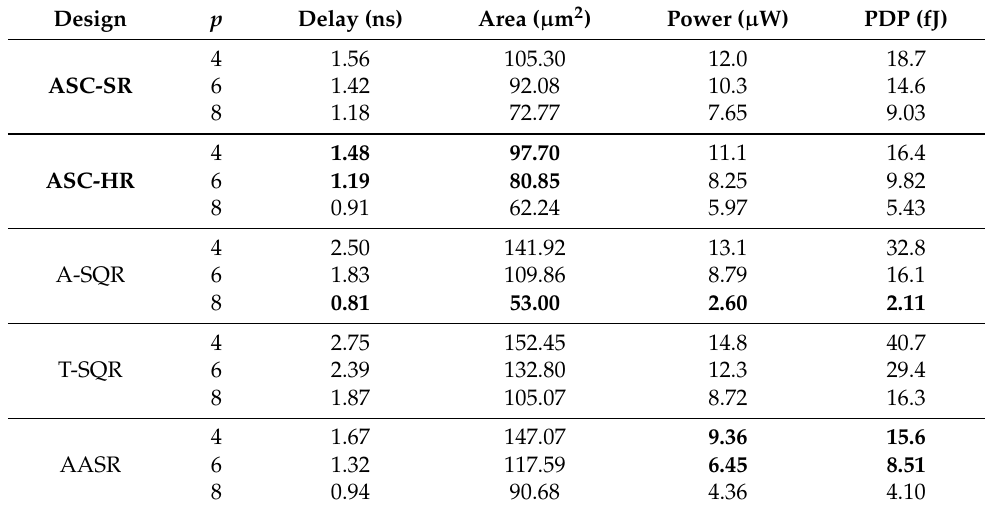
Table 3. Hardware evaluation results (proposed designs and best results shown in bold font).